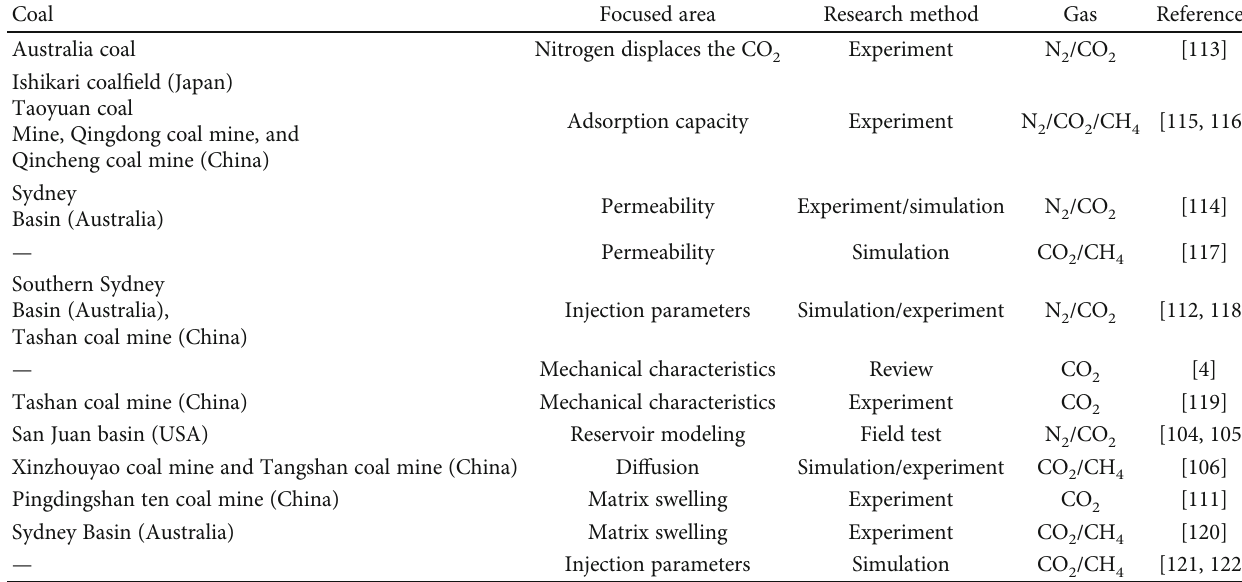
Table 2: The summary of gas injection for improving methane